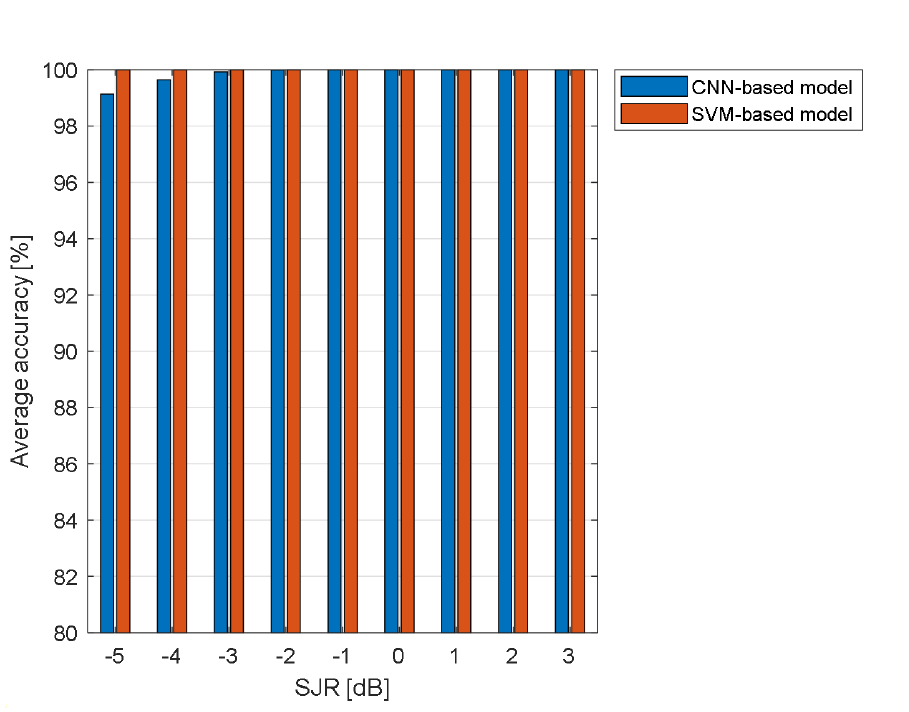
Figure 13. Results of the proposed SVM-Based and CNN-based classification methods when HG modes are considered.